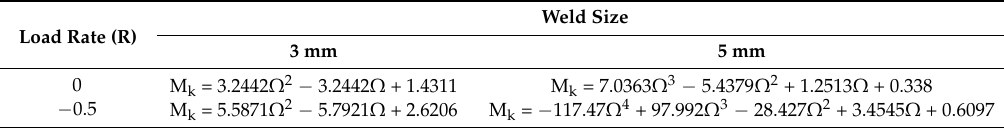
Table 9. Adjusted expressions for the modified weld magnification factor M k for the condition of post weld cooling in